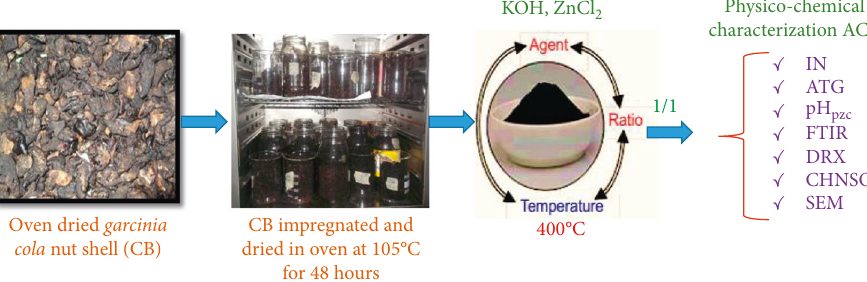
Figure 1: Preparation and characterization of activated carbons.